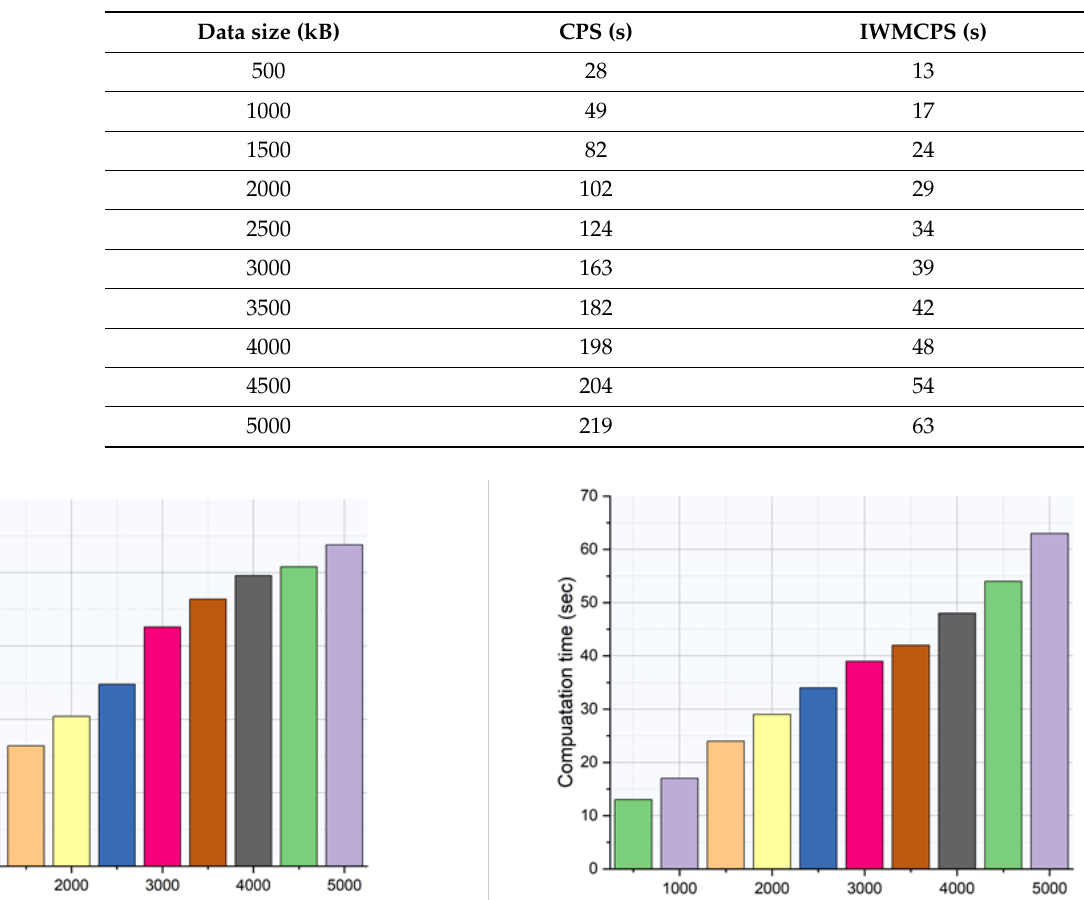
Table 2. Computation time analysis.